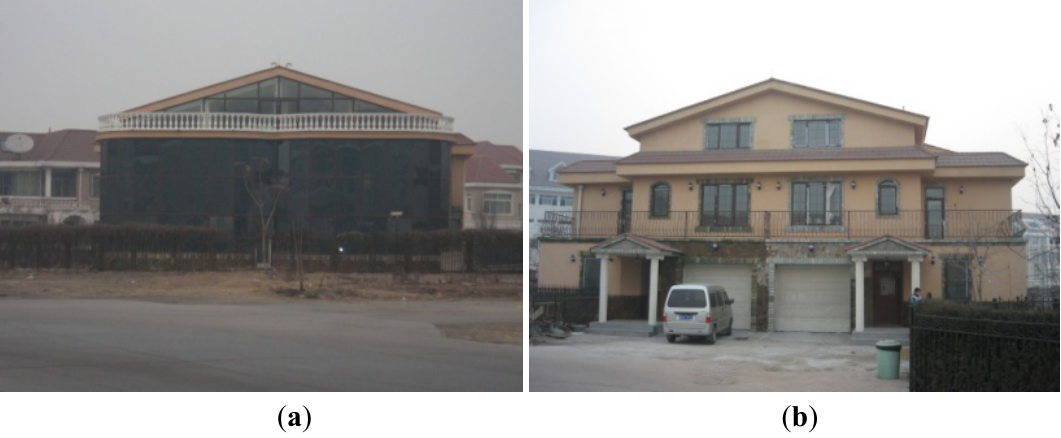
Figure 1. Pictures showing the appearance the demonstration building. ( a ) South view; ( b ) North view.